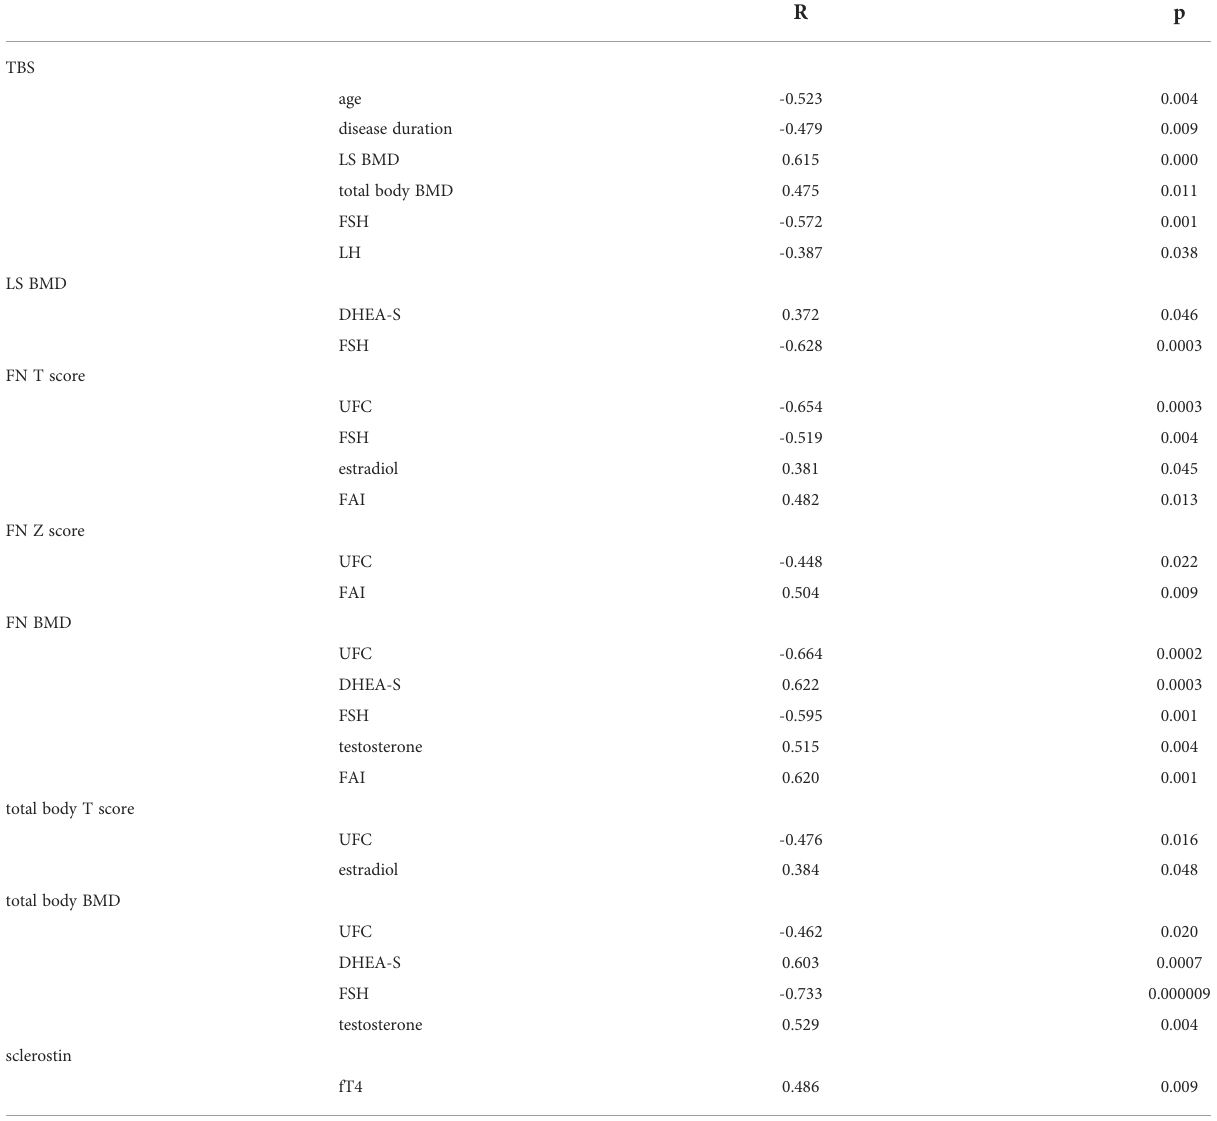
TABLE 3 Correlations between TBS/densitometry parameters/sclerostin and other clinical characteristics in 29 patients with autoimmune primary adrenal insuf fi ciency.